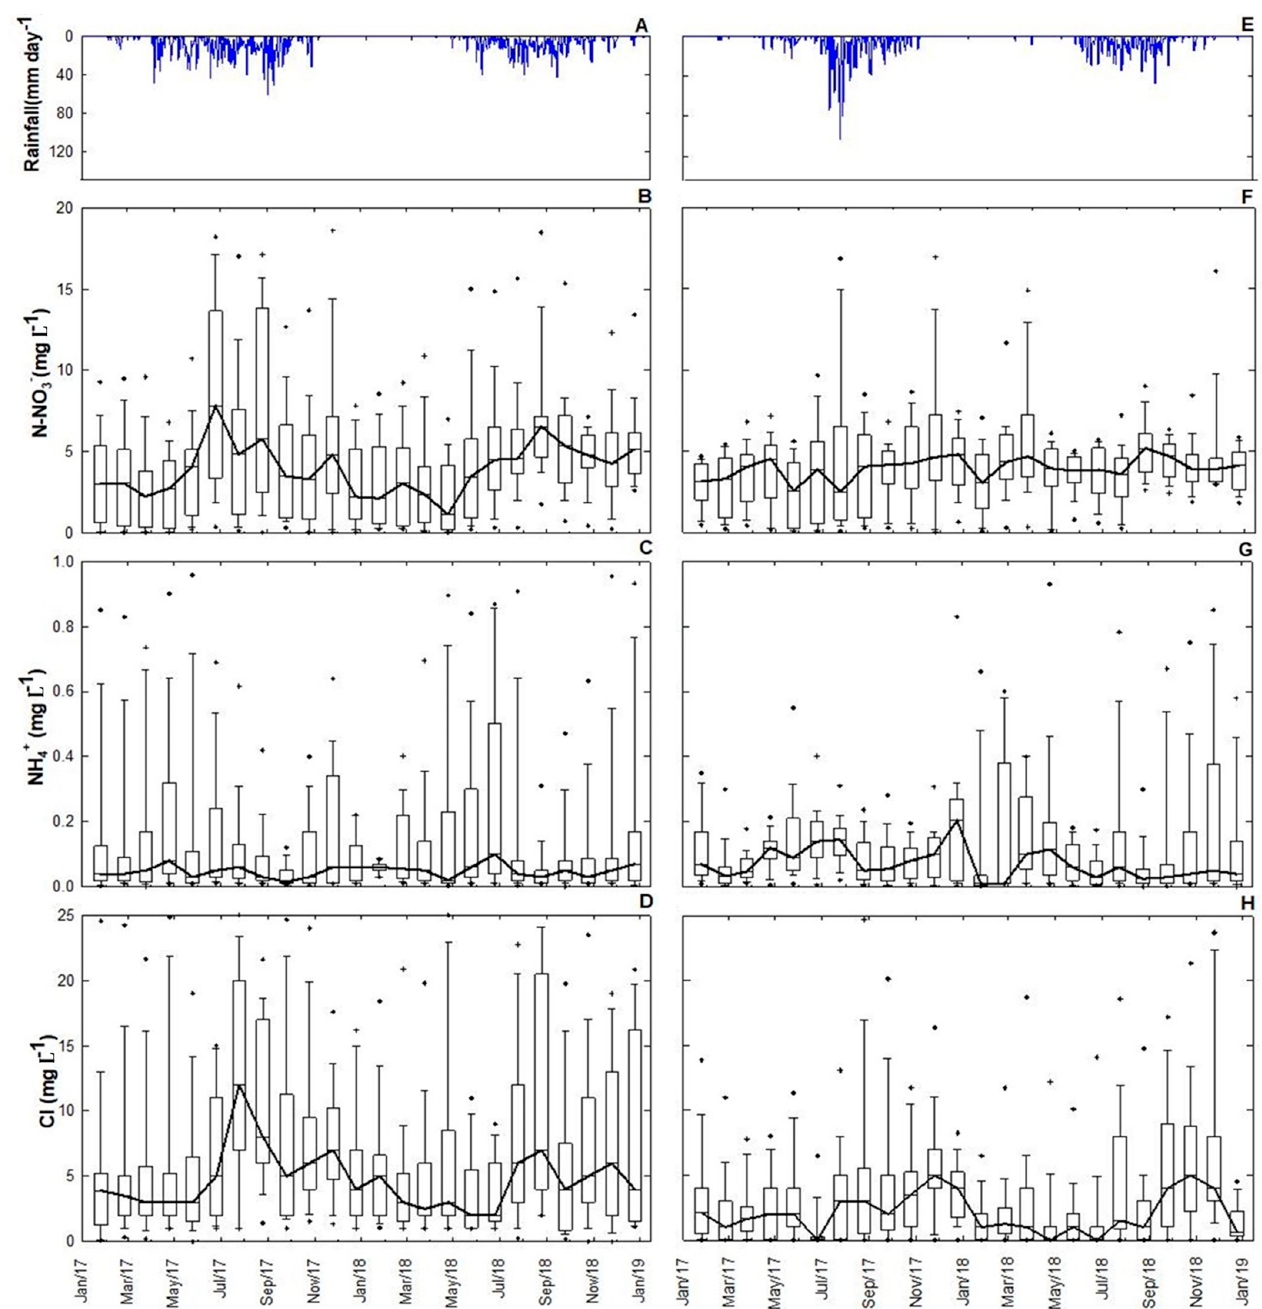
Figure 7. Box plots indicating perched groundwater nitrate ammonium and chloride concentrations in 2017 and 2018. ( A – D ) is for Dangishta, and ( E – H ) is for Robit Bata. Each box plot is based on data from 32 wells in Dangishta and 35 in Robit Bata. The dots placed above and below whiskers indicate outliers.